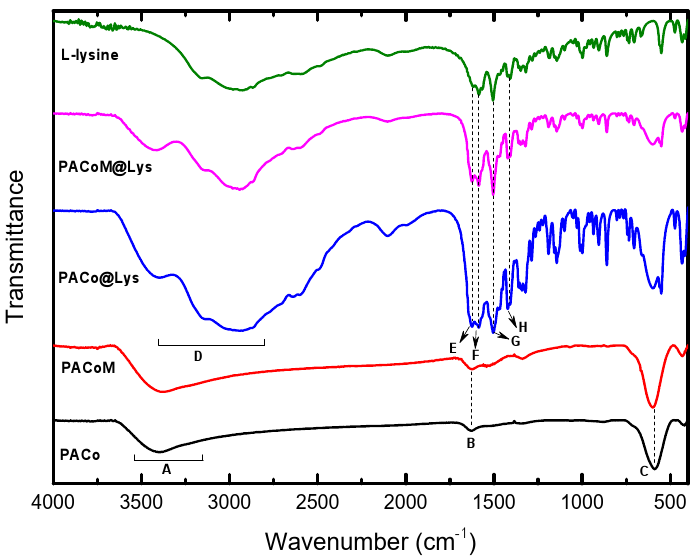
Figure 5. FTIR spectra of the pure commercial L-lysine monohydrochloride, nanoadsorbent samples (PACo–Lys and PACoM–Lys), and precursor nanoparticles (PACo and PACoM).